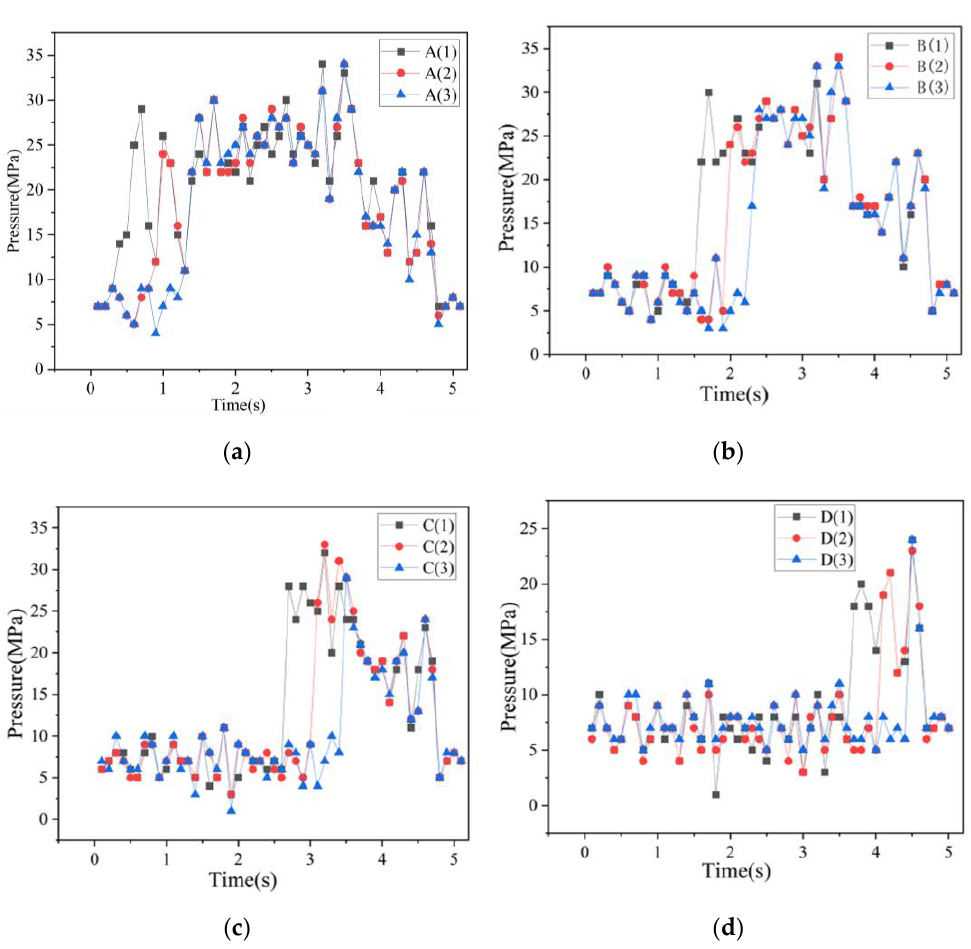
Figure 4. Pressure sensor values for each monitoring section: ( a ) A observation area; ( b ) B observation area; ( c ) C observation area; ( d ) D observation area.